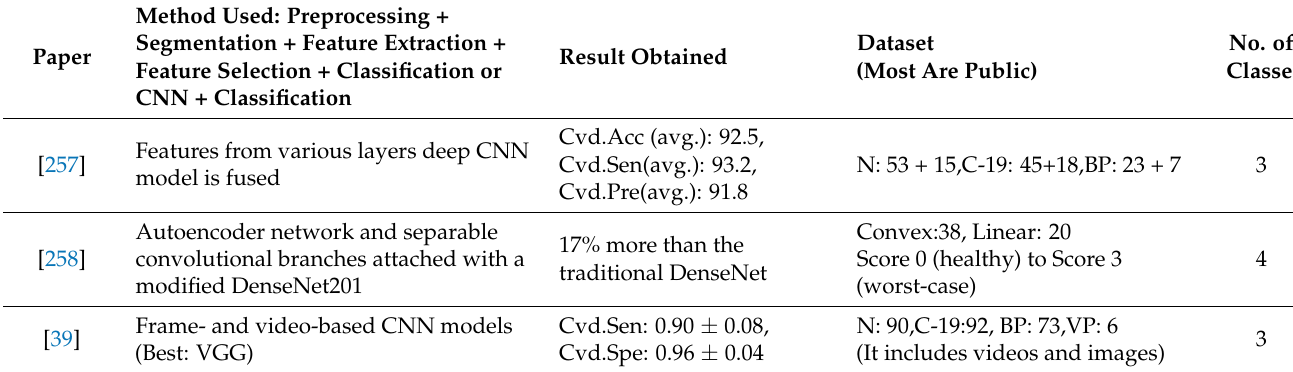
Table 4. State-of-the-art AI techniques to detect COVID-19 using lung US imagery.